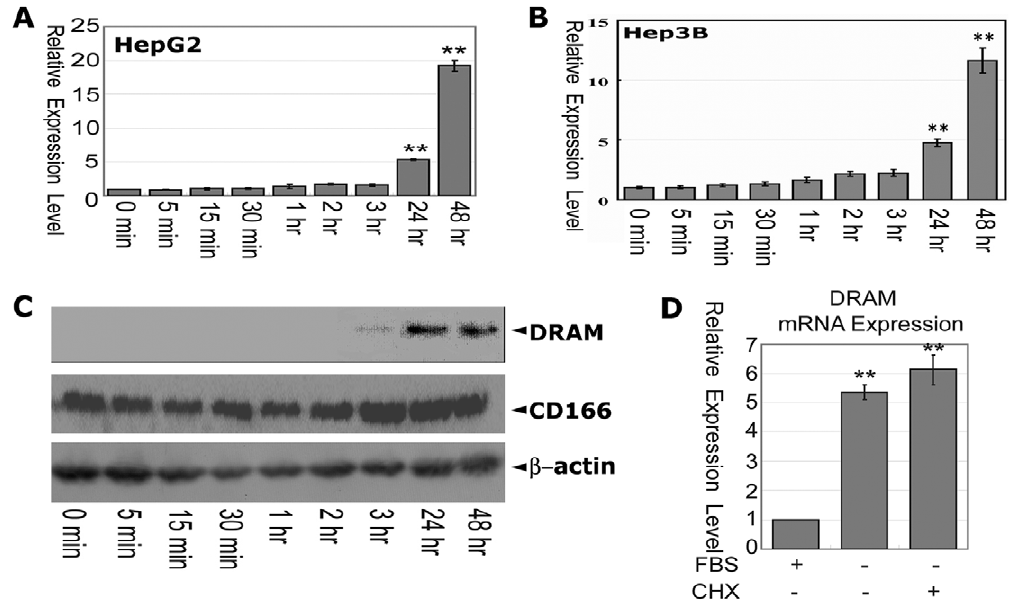
Figure 1. Serum deprivation induces DRAM expression in liver cancer cells. (A) mRNA level of the DRAM gene upon serum deprivation at different time points were quantified by real-time RT-PCR in HepG2 cells. (B) DRAM expression in Hep3B cells is similar to that observed in HepG2 cells. (C) Analysis of the DRAM protein expression in HepG2 cells. CD166 served as a positive control for serum starvation induced protein expression. Cells were grown to 70% confluency in DMEM containing 10% FBS. These cells were washed with PBS and fed with DMEM media omitting FBS for various time points. The resulting cells were harvested and the total RNAs and whole cell lysates were extracted and the expression of DRAM mRNA and protein was examined by qRT-PCR or western blot. GAPDH were used as an internal control. (D) Inhibition of protein synthesis does not affect serum starvation-induced DRAM expression in HepG2 cells. Cells were treated with CHX (10 mM) under serum deprivation for 24 hrs, and total RNA was extracted for analysis of the DRAM expression by real-time PCR. All results are presented as means 6 S.D. of three independent experiments. **, p , 0.01 level using t-test.